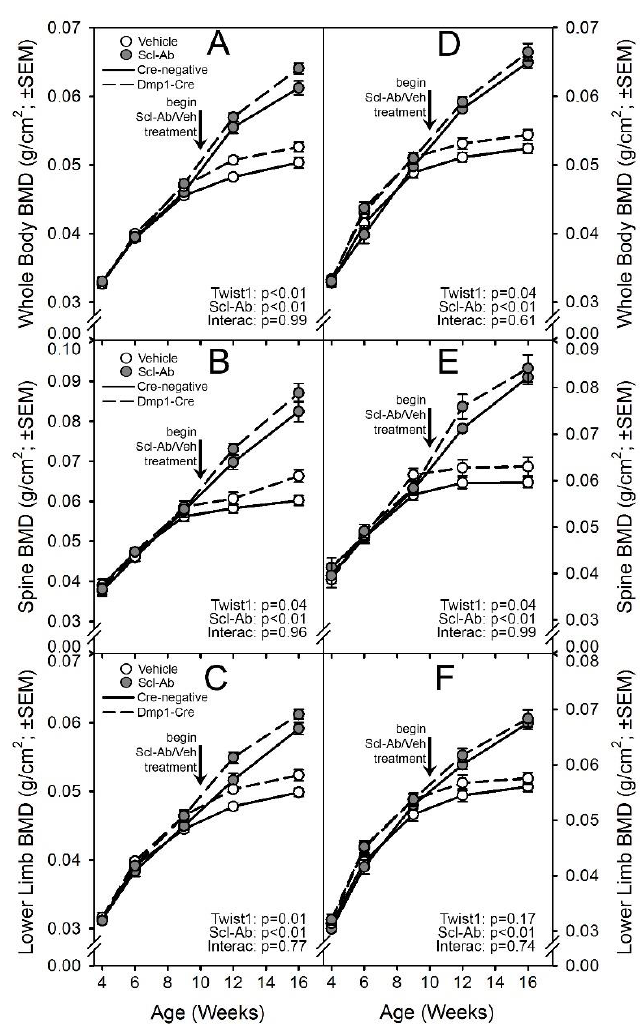
Figure 2. Serial in vivo DXA scans of Cre-negative (solid lines) and 10kb Dmp1-Cre-positive (broken lines) Twist1 f/f mice, treated twice per week with vehicle control (open circles) or 25 mg/kg sclerostin antibody (Scl-Ab; filled circles). Scans were collected every 2–4 wk and analyzed for ( A , D ) whole-body BMD, ( B , E ) lumbar spine BMD, and ( C , F ) BMD of the right hindlimb distal to the acetabulum. Panels A–C display data from female mice; panels D–F display data from male mice. Antibody/vehicle treatment began at 10 wk of age, indicated by the vertical arrow. The longitudinal data were tested for significance of both main effects and an interaction using rmANOVA, reported in the corner of each panel; n = 8–11/group.